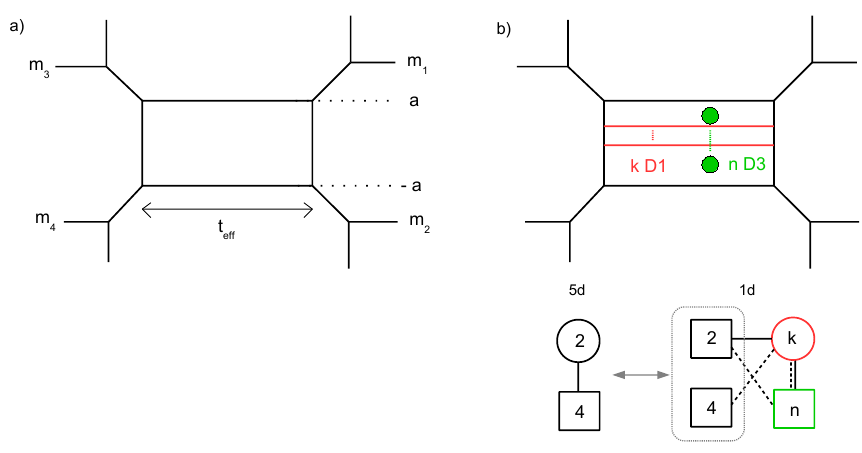
Figure 16 . Brane realization of the SU(2) theory with N f = 4 and brane setup ADHM quiver SQM for the k -instanton